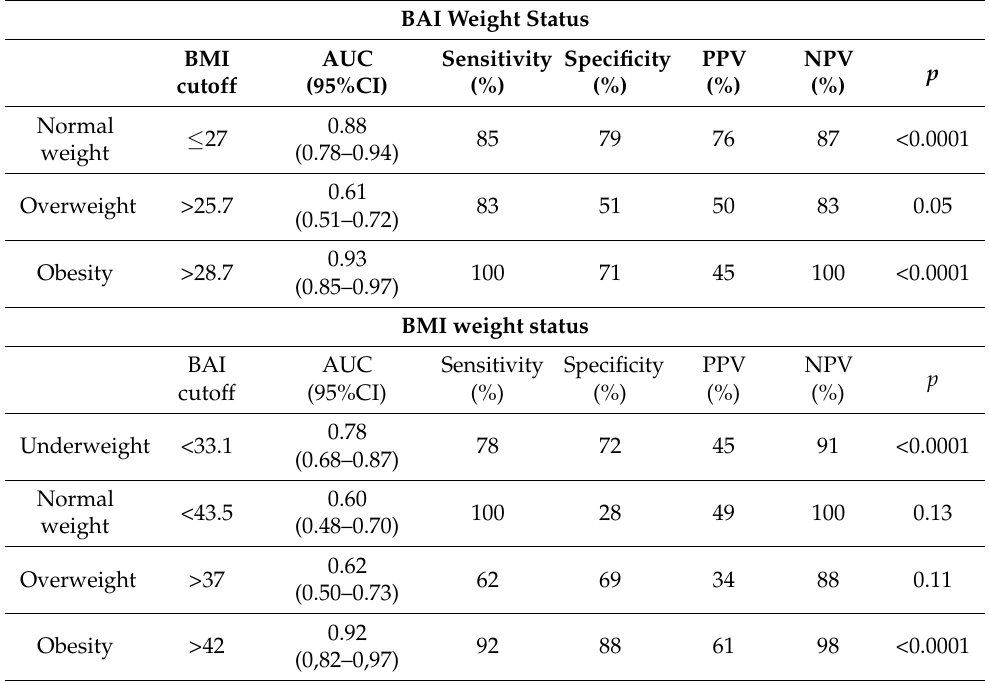
Table 4. Receiver-operating characteristics (ROC) curves identifying the discrimination thresholds of BAI and BMI for each weight status categories set out by BAI and